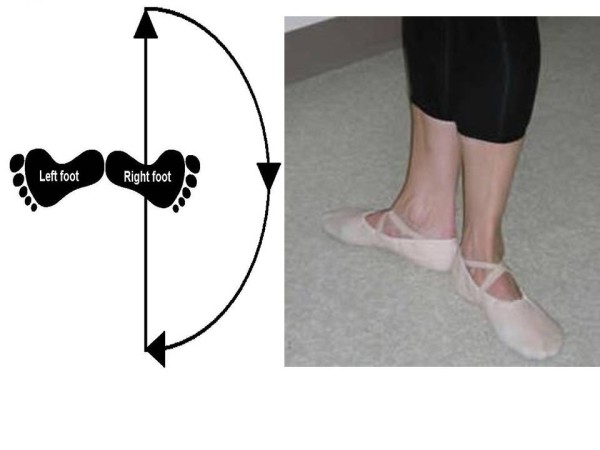
"En dehor" position.